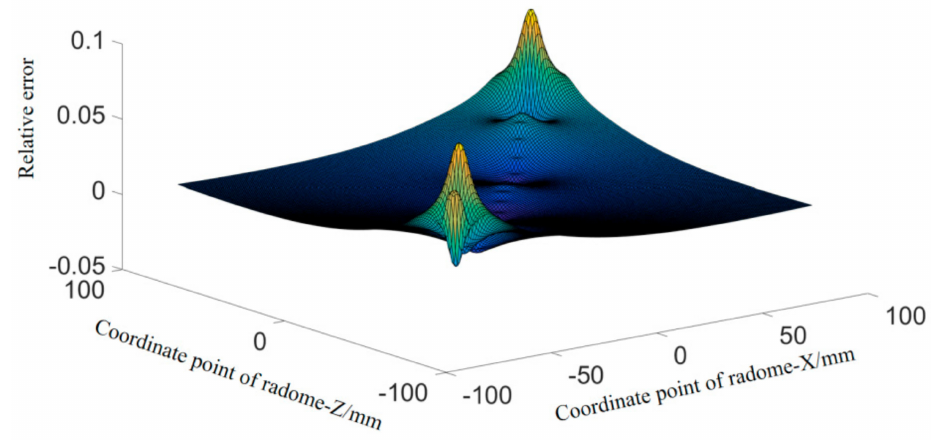
Figure 5. Accuracy error “cloud